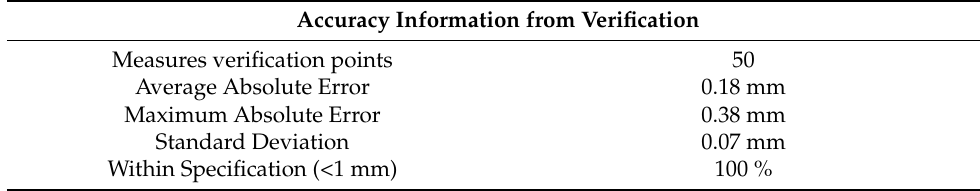
Table 3. “Birth certificate” of the owned IRB 2400 robot.